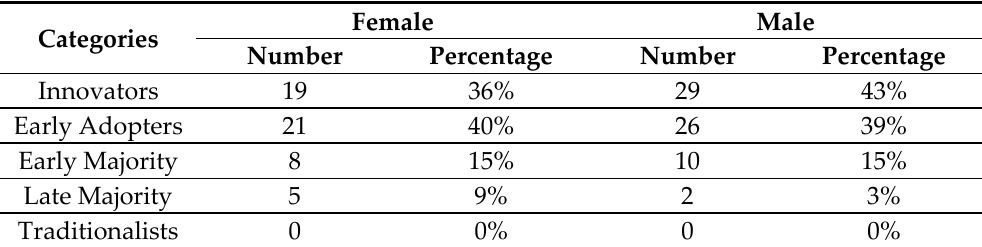
Table 8. Analysis according to gender.